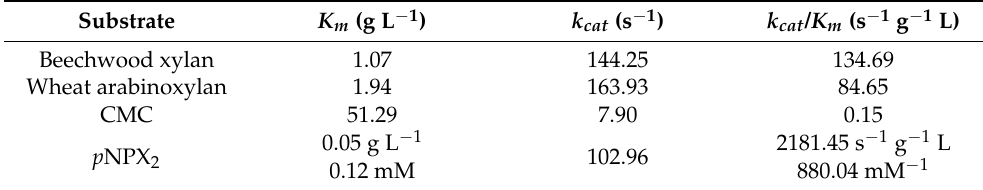
Table 2. Kinetic parameters of rXynSOS with different